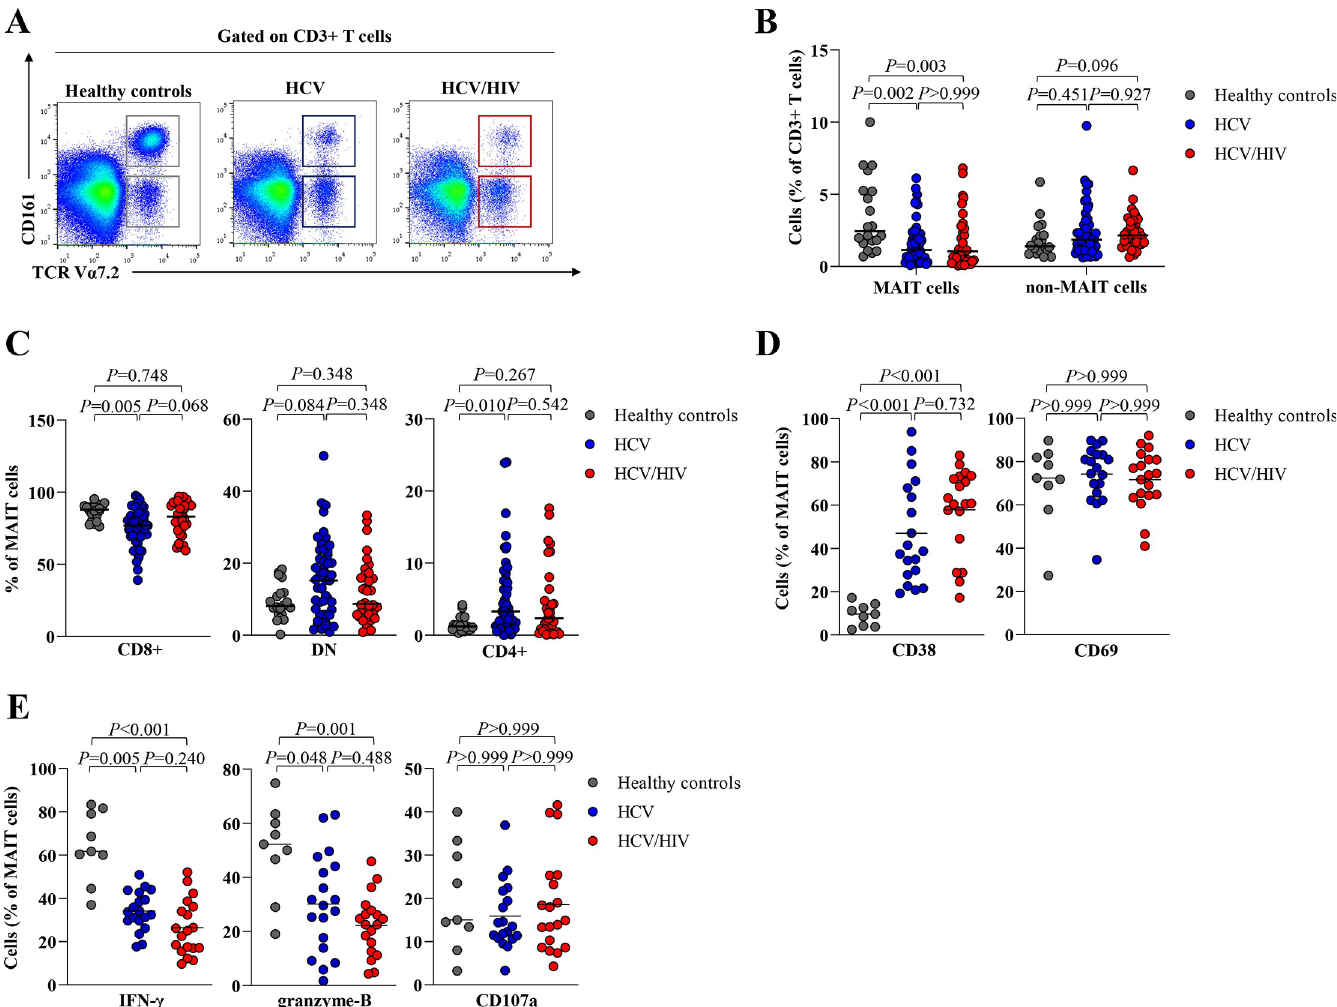
Fig 1. Frequency of MAIT cells and non-MAIT cells in healthy controls and HCV-infected patients. (A) Representative dot plots for identification of TCRV α 7.2 +CD161++ or MAIT cells and TCR α 7.2+ CD161 − or non-MAIT cells. FSC-A, forward scatter area; SSC-A, side scatter area. (B) Percentage of MAIT and non-MAIT cells in blood of healthy controls, HCV-monoinfected patients (HCV) and HCV/HIV-coinfected patients (HCV/HIV). (C) Percentage of CD8+, CD4+ and double negative (DN) MAIT cell subsets in blood. (D) Frequency of CD38+ and CD69+ MAIT cells. (E) Frequency of polyfunctionality; IFN- γ , cytolytic function marker; granzyme-B and cytotoxicity marker; CD107a-positive MAIT cells after overnight stimulation with IL-12/IL18. Data presented as median and interquartile range (IQR). Statistical analysis was performed using Kruskal–Wallis, followed by a multiple comparison test.